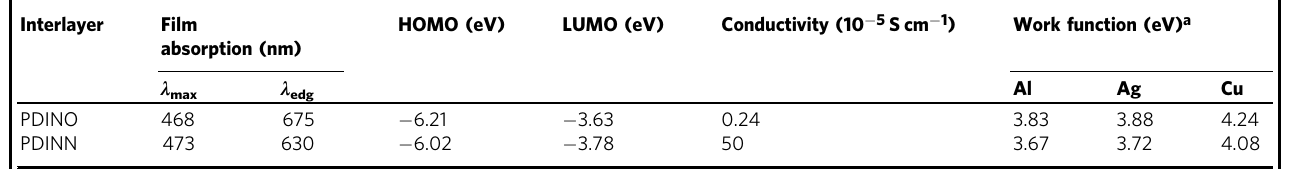
Table 1 Comparison of the physicochemical properties of the CIMs of PDINO and PDINN. Interlayer